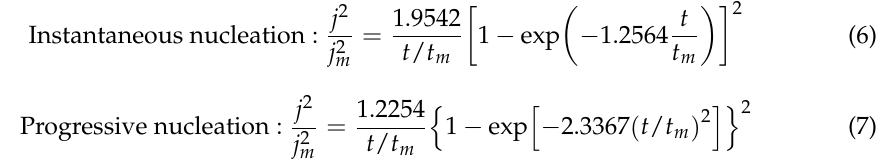
which is related to the existence of reactions concomitant with the nucleation and growth mechanisms, such as protons or residual water reduction